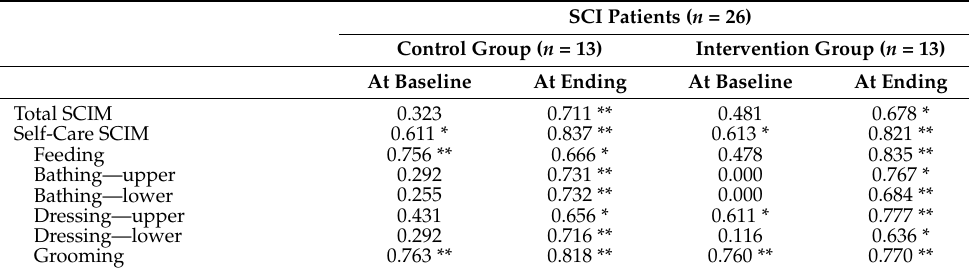
Table 3. Correlation coefficient between the total CUE score and SCIM clinical scale at baseline and ending for both experimental